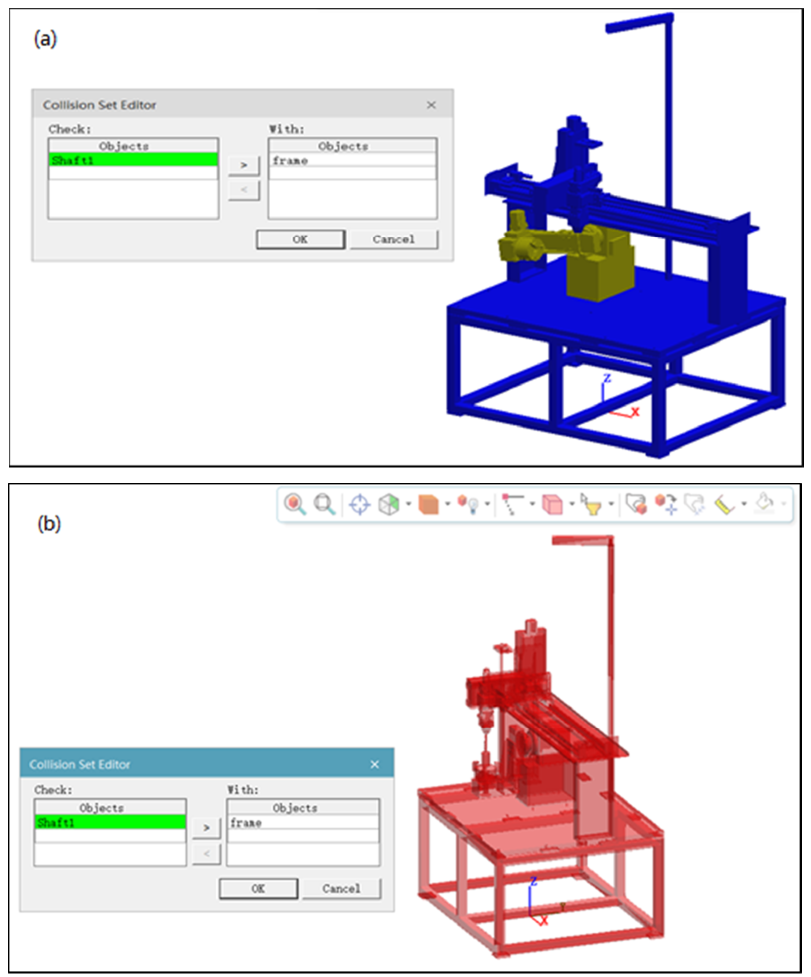
Figure 6. Collision inspection of LMD equipment model: ( a ) no detection of collision; ( b ) detection of collision and alarm.